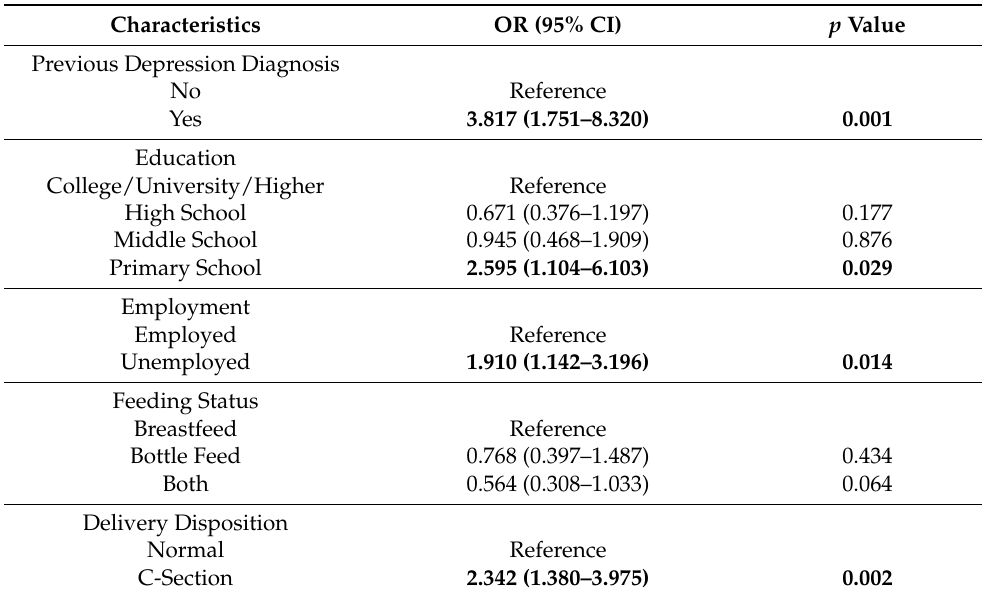
Table 3. Multivariate regression analysis of association between sociodemographic, clinical character- istics and